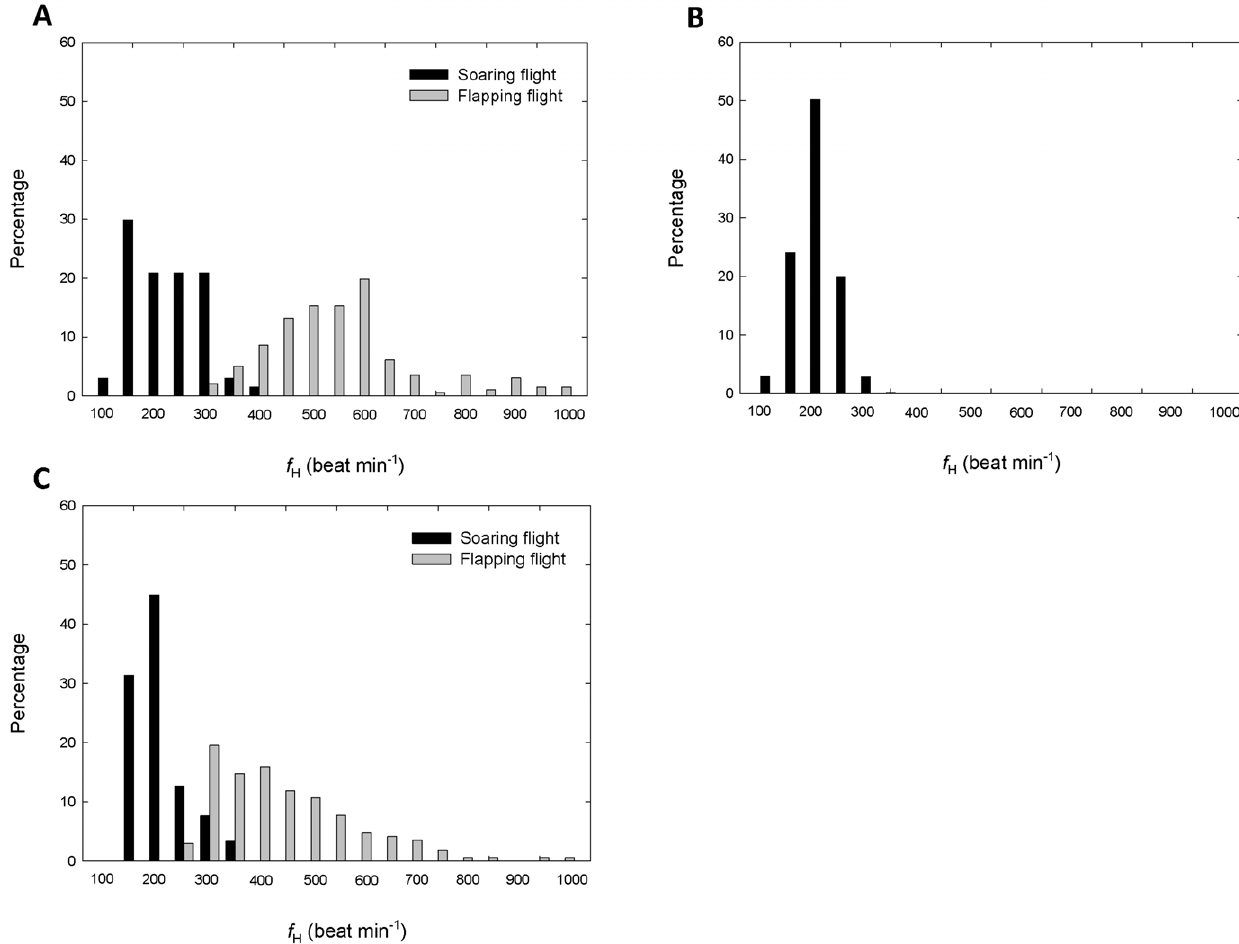
Figure 5. Distribution of heart beat frequency ( f H ) of European bee-eaters during different activities and migration stages. (A) Soaring and flapping flights during stopover. (B) Rest during stopover. (C) Soaring and flapping during cross-country flight.